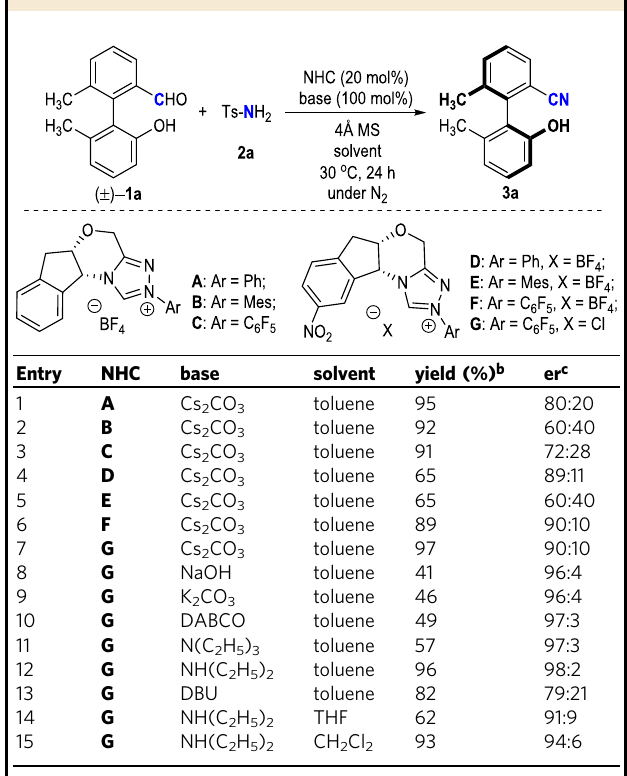
Table 1 Optimization of reaction conditions a